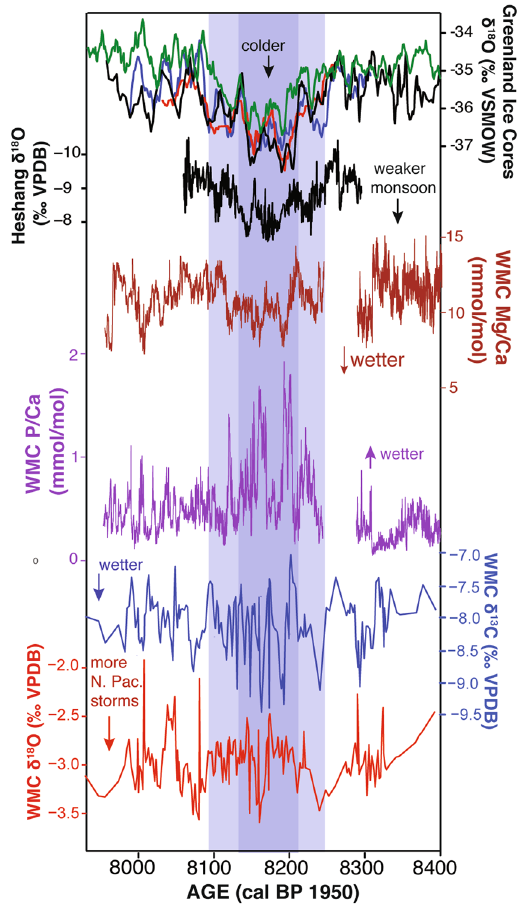
Figure 3. High resolution records of the 8.2 ka event. From top to bottom: Greenland ice core δ 18 O from GRIP (red), GISP2 (black), NGRIP (blue), and Dye 3 (green) on the GICC05 time scale 2 ; the updated Heshang Cave δ 18 O record (black) 42 ; WMC1 Mg/Ca (brown); P/Ca (purple); δ 13 C (blue); and δ 18 O (red) (this study). Dark and light blue shading depict, respectively, the central portion and entire duration of the 8.2 ka event as described in ref. 2 based on the Greenland ice core